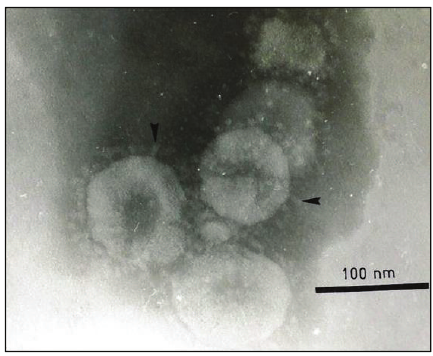
Figure 9: Negative staining electron microscope showing spherical shape of virus with typical spike projections (arrow) surrounding the virion of avian infectious bronchitis virus (courtesy: Siti Suri Arshad).